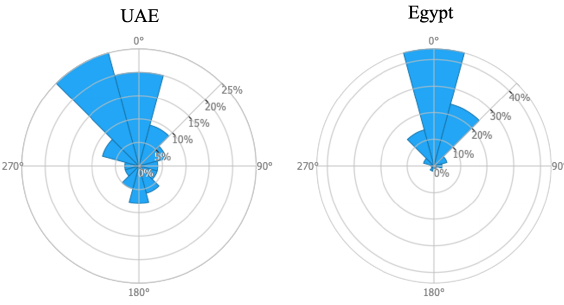
Figure 6. Average of wind blow direction in the considered study areas between 2008 and 2017 (wind data: c (cid:13) 2019 DTU,